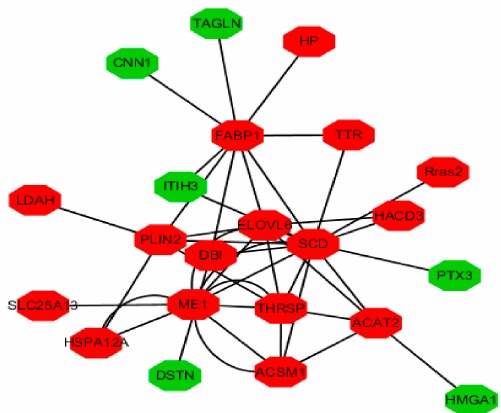
Figure 3. The interaction networks of DEPs related to fat metabolism in the adipose tissue of FYs and MYs. The red expressed the upregulated expression of protein in the adipose tissue of FY, and the green expressed the downregulated expression of protein in the adipose tissue of